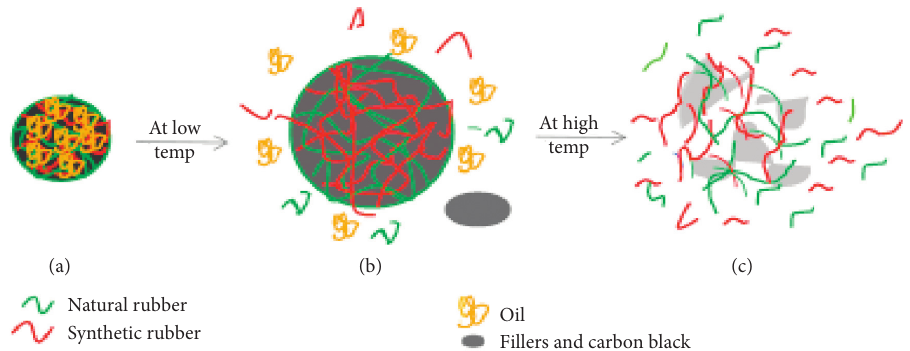
Figure 3: CR swelling and degradation in asphalt [36]. (a) Crumb rubber (CR). (b) Swollen CR, discharging oil and fillers to asphalt. (c) Breaking of